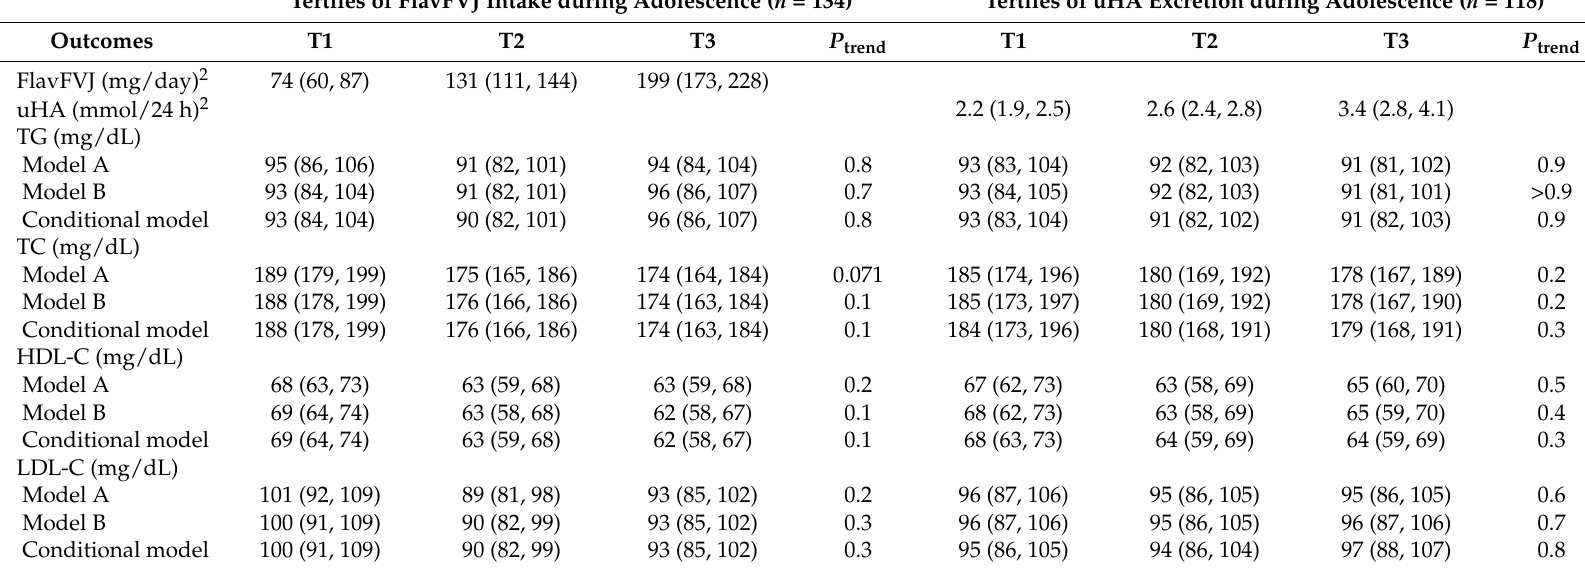
Table 3. Prospective associations of dietary flavonoid intake from fruit and vegetables including juices (FlavFVJ) and urinary hippuric acid (uHA) excretion during adolescence with serum lipid levels in early adulthood among females 1